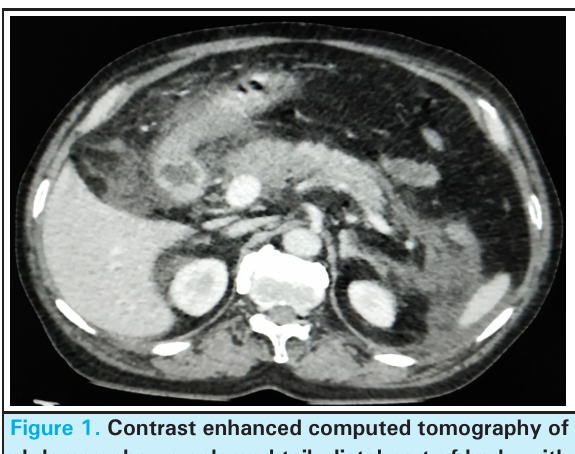
Figure 1. Contrast enhanced computed tomography of abdomen shows enlarged tail, distal part of body with indistinct margin, normal enhancement and peritoneal collection.